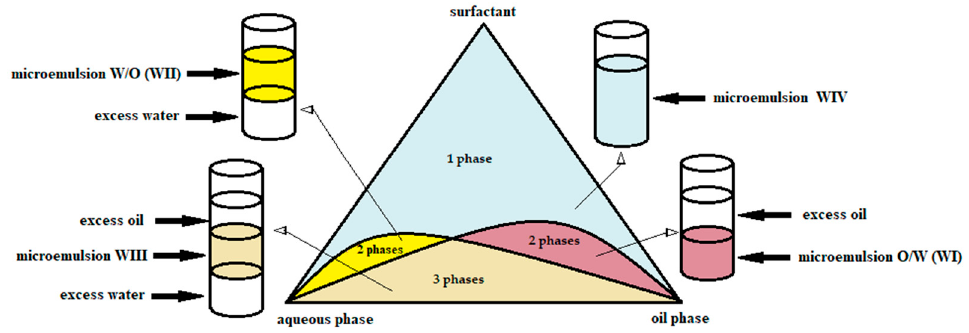
Figure 1. Ternary diagram schematized to determine the microemulsion region. Table 1. Formulation of the microemulsion-based drilling